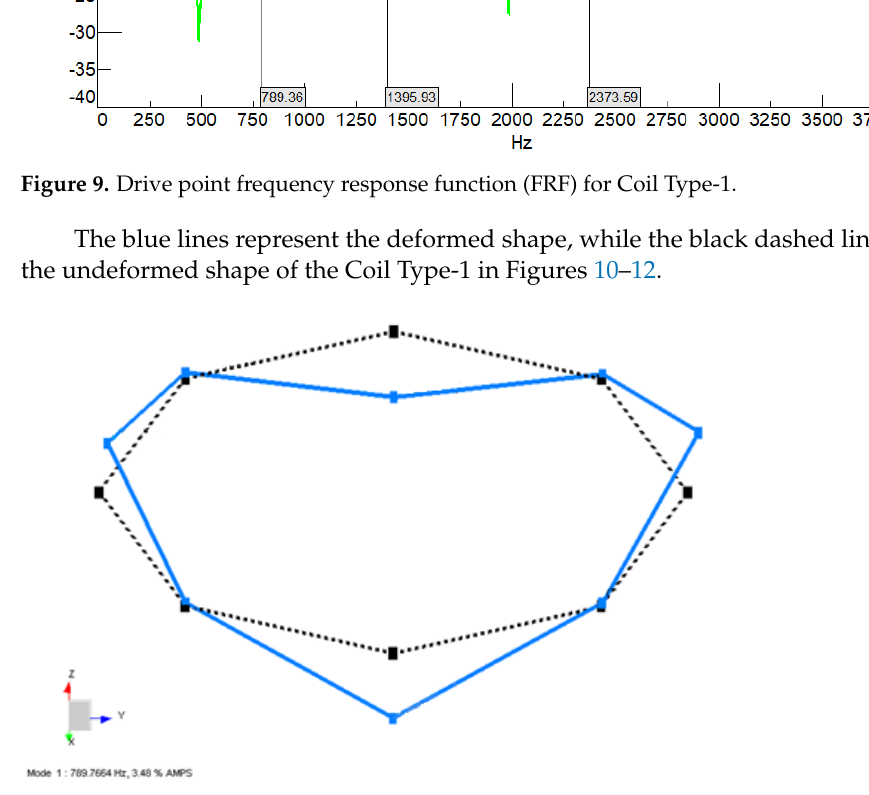
Figure 10. First mode shape obtained from LMS Test Lab software for a Type-1 coil sample.